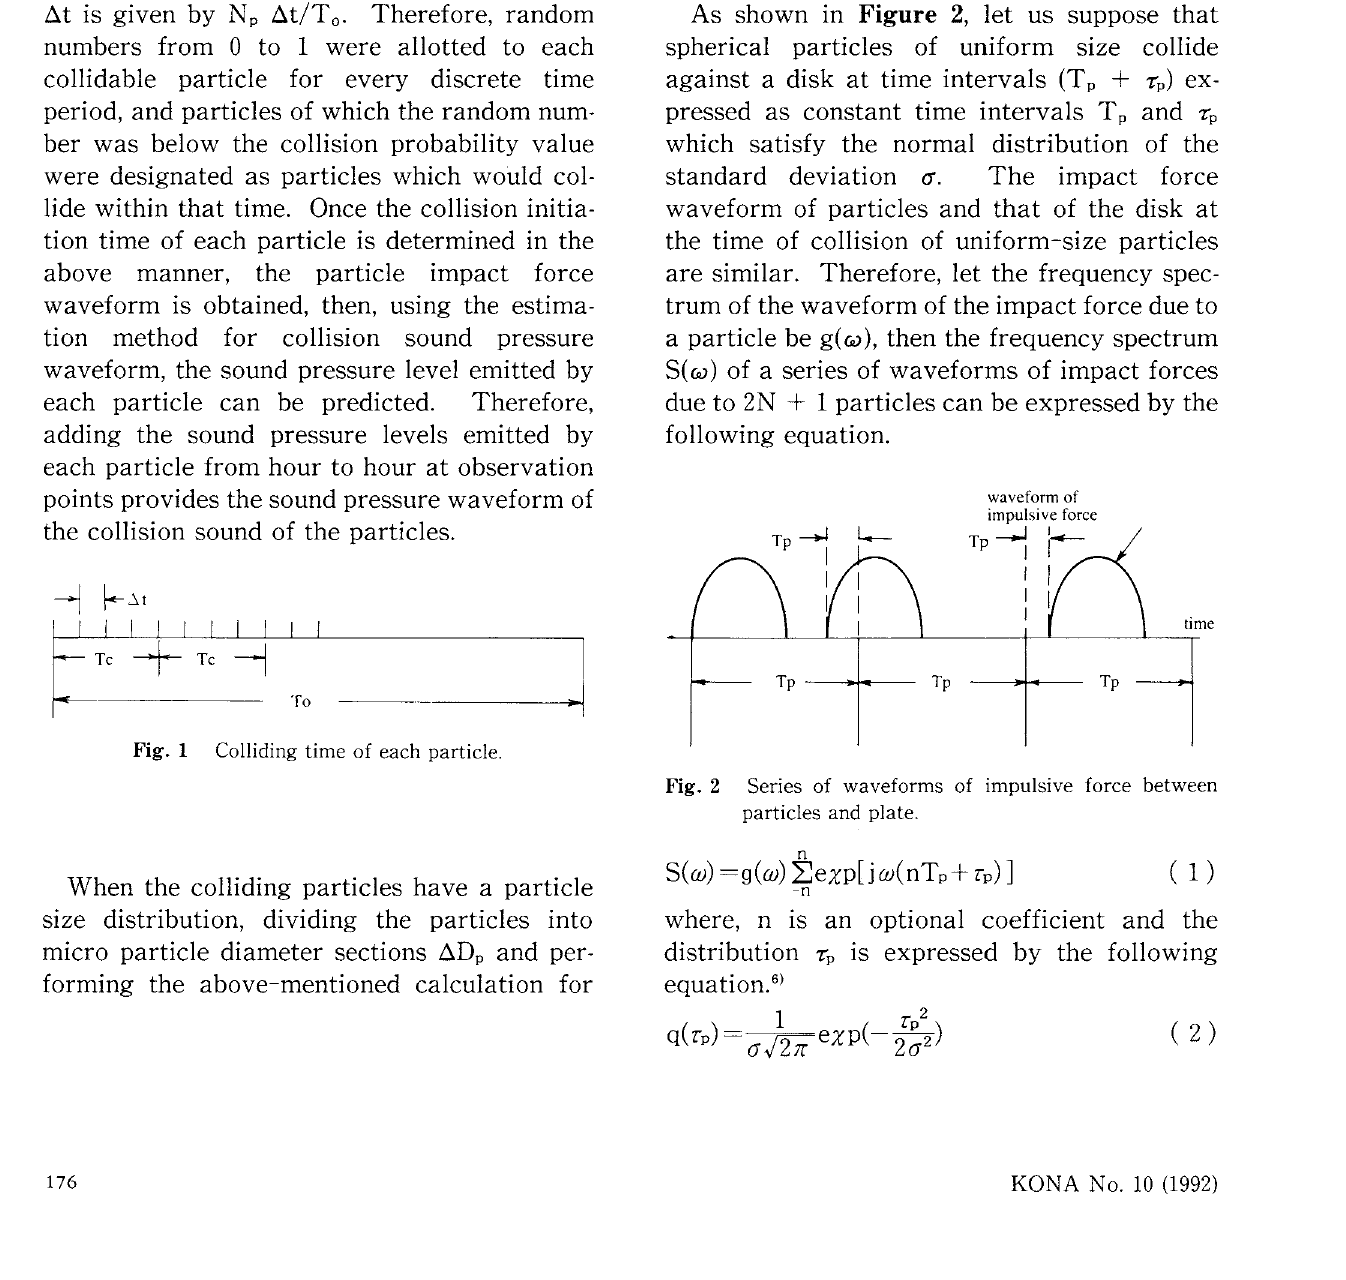
Series of waveforms of impulsive force between particles and